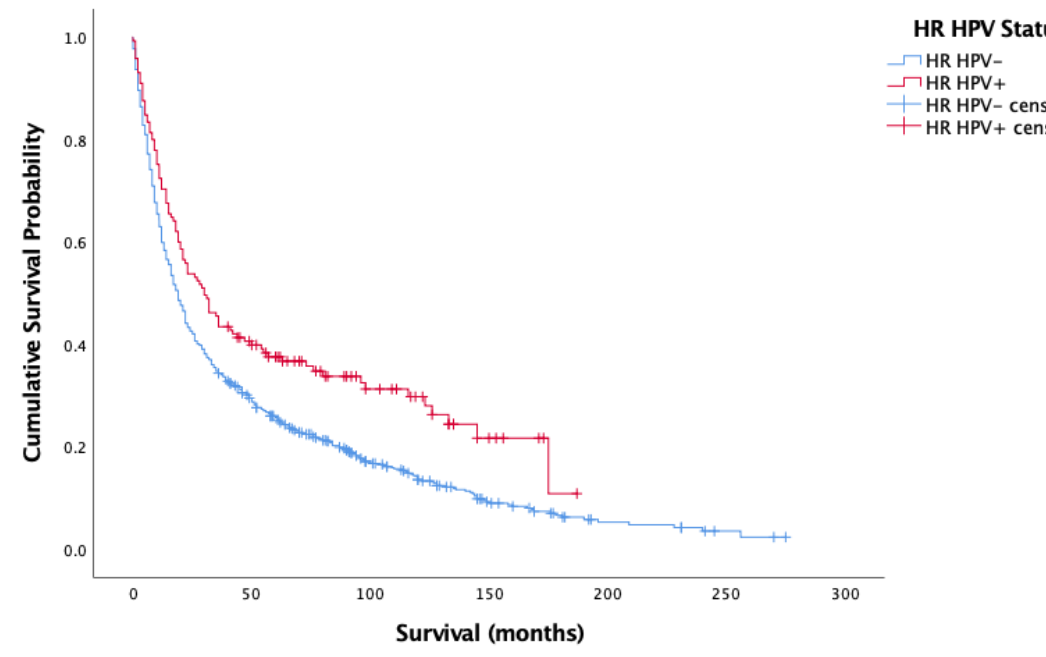
Figure 1. Kaplan – Meier analysis of overall survival in months based on HR HPV status for oropha- ryngeal, oral cavity, and laryngeal cancer (n = 861).